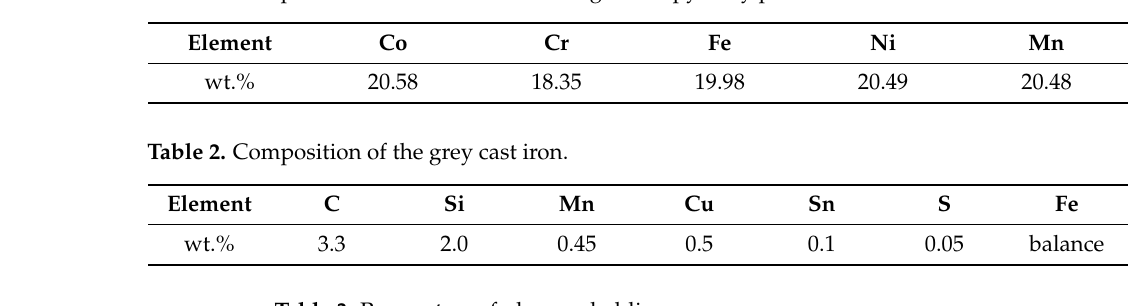
Figure 2. XRD pattern of CoCrFeNiMn powder. Figure 1. Microstructure of CoCrFeNiMn powder: ( a ) global morphology, ( b ) cross-sectional microstructure .